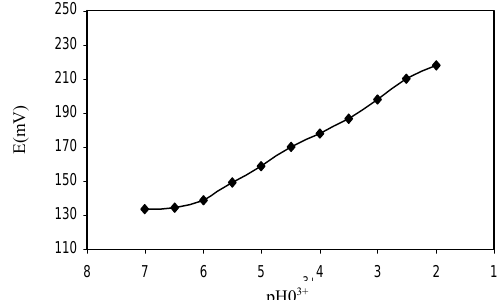
Figure 2. Calibration curve of holmium electrode based on OID